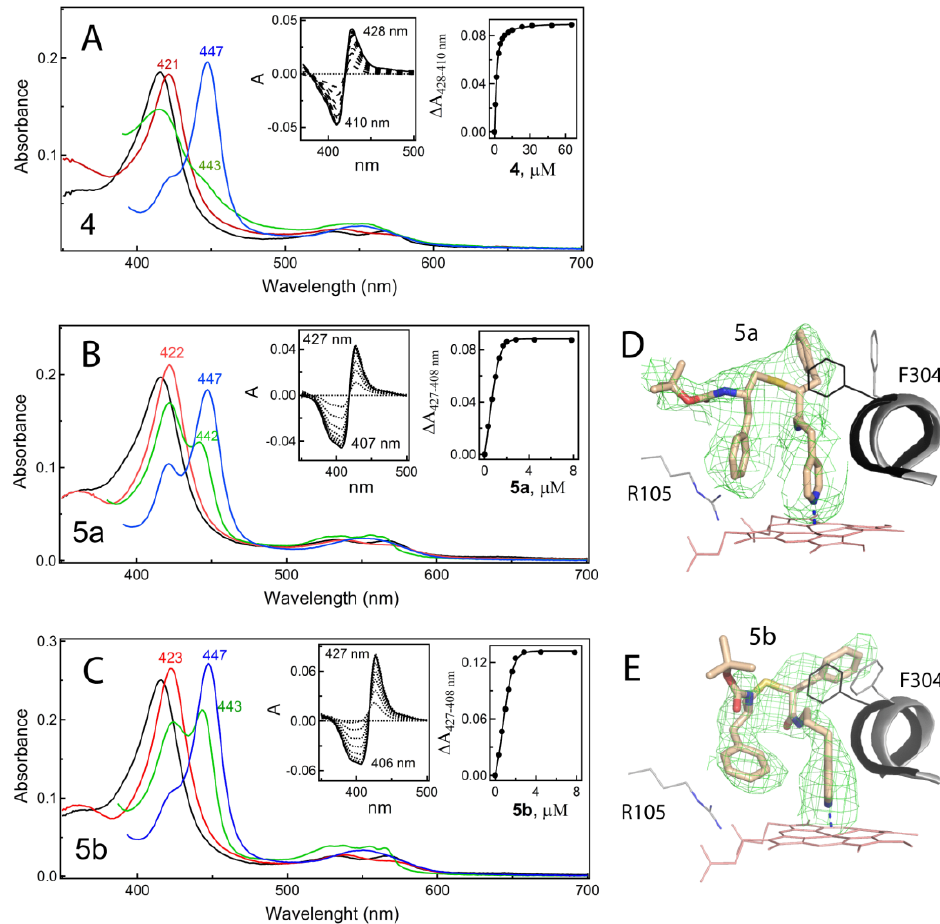
Figure 3. Spectral properties of 4 and 5a,b and the binding modes of the latter two compounds. ( A – C ) Ligand-induced spectral changes in CYP3A4. Absorbance spectra of ferric ligand-free and inhibitor-bound CYP3A4 are in black and red, respectively. Spectra of ferrous ligand-bound CYP3A4 and its CO adducts are in green and blue, respectively. Left insets are the difference spectra recorded during equilibrium titrations; right insets are the titration plots with quadratic fittings. The derived spectral dissociation constants (K s ) are given in Table 1. ( D , E ) Crystallographic binding modes of 5a and 5b , respectively. Part of the adjacent I-helix and Phe304 in the inhibitory complexes and water-bound CYP3A4 (5VCC structure) are depicted in gray and black, respectively. Polder omit electron density maps contoured at 3 σ level are shown as green mesh. The 5a - and 5b -bound structures of CYP3A4 have the PDB ID codes 7UF9 and 7UFA, respectively.